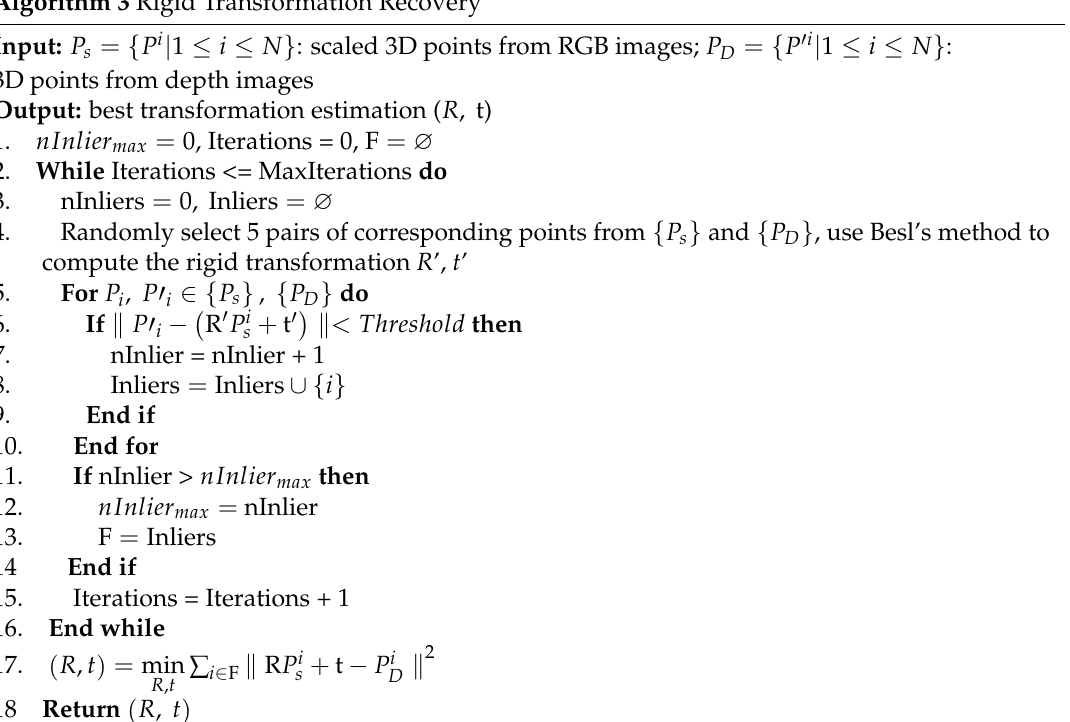
Algorithm 3 Rigid Transformation